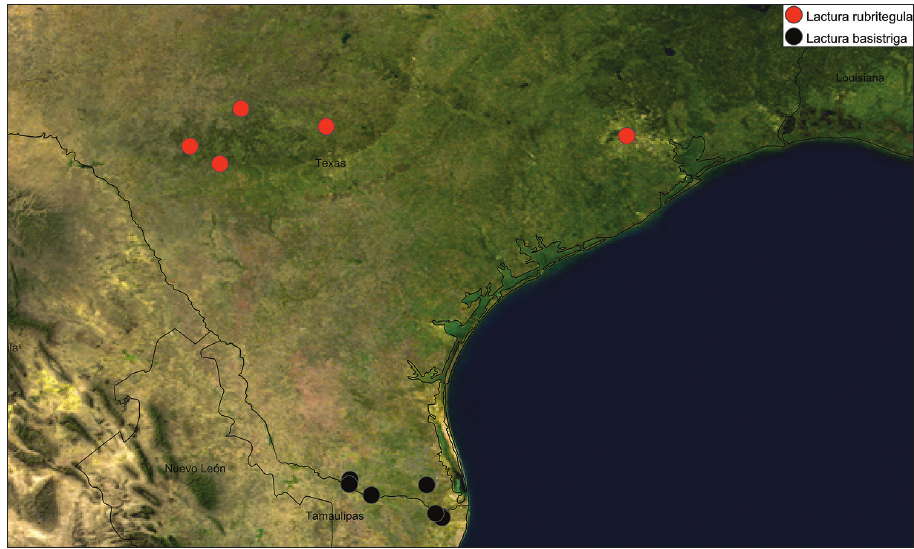
Figure 9. Geographic distribution of Lactura rubritegula (n=21, red) and Lactura basistriga (n=17, black). Single dots may represent >1